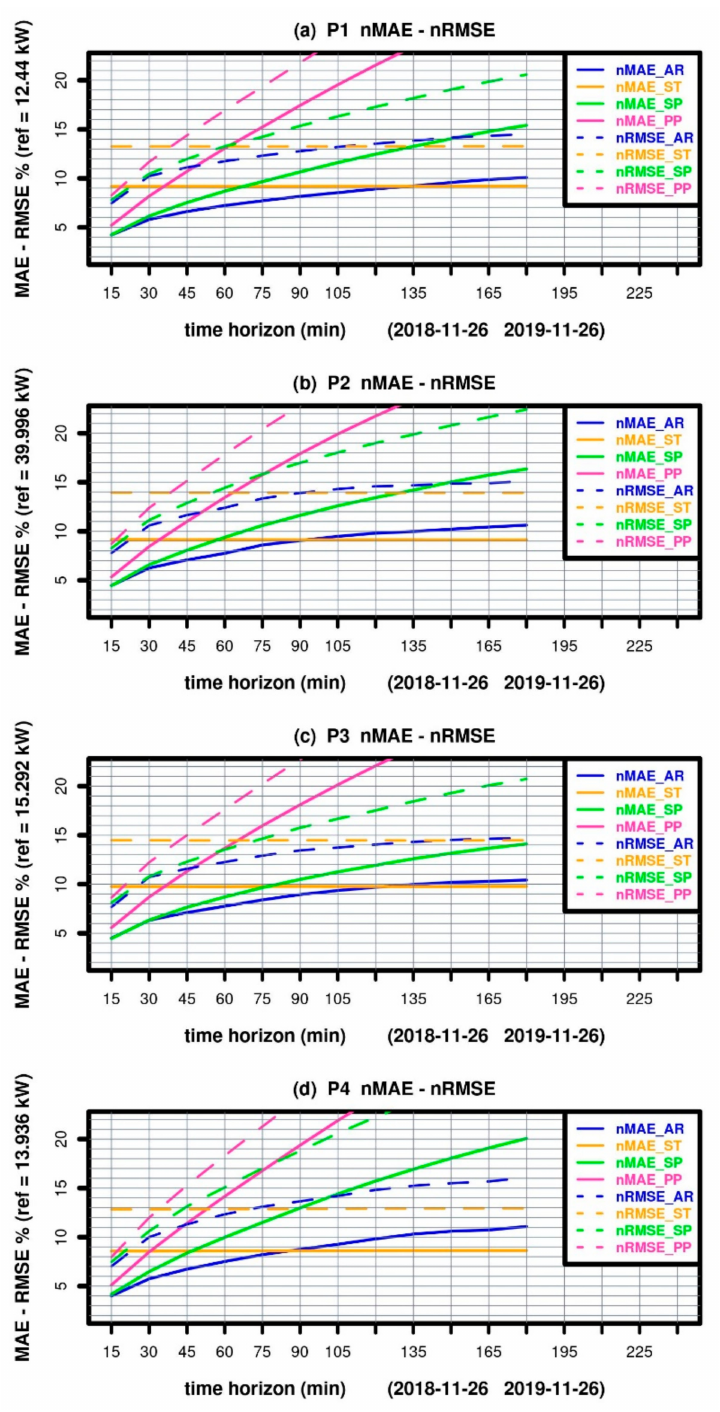
Figure 8. nMAE (solid) and nRMSE (dashed) errors as a function of the prediction horizon for ARIMAX( AR ) in blue, optimized short-term (ST) forecasting in orange, smart persistence (SP) in green and pure persistence (PP) in pink, related to the plants P1 in the panel ( a ), P2 in ( b ), P3 in ( c ) and P4 in ( d